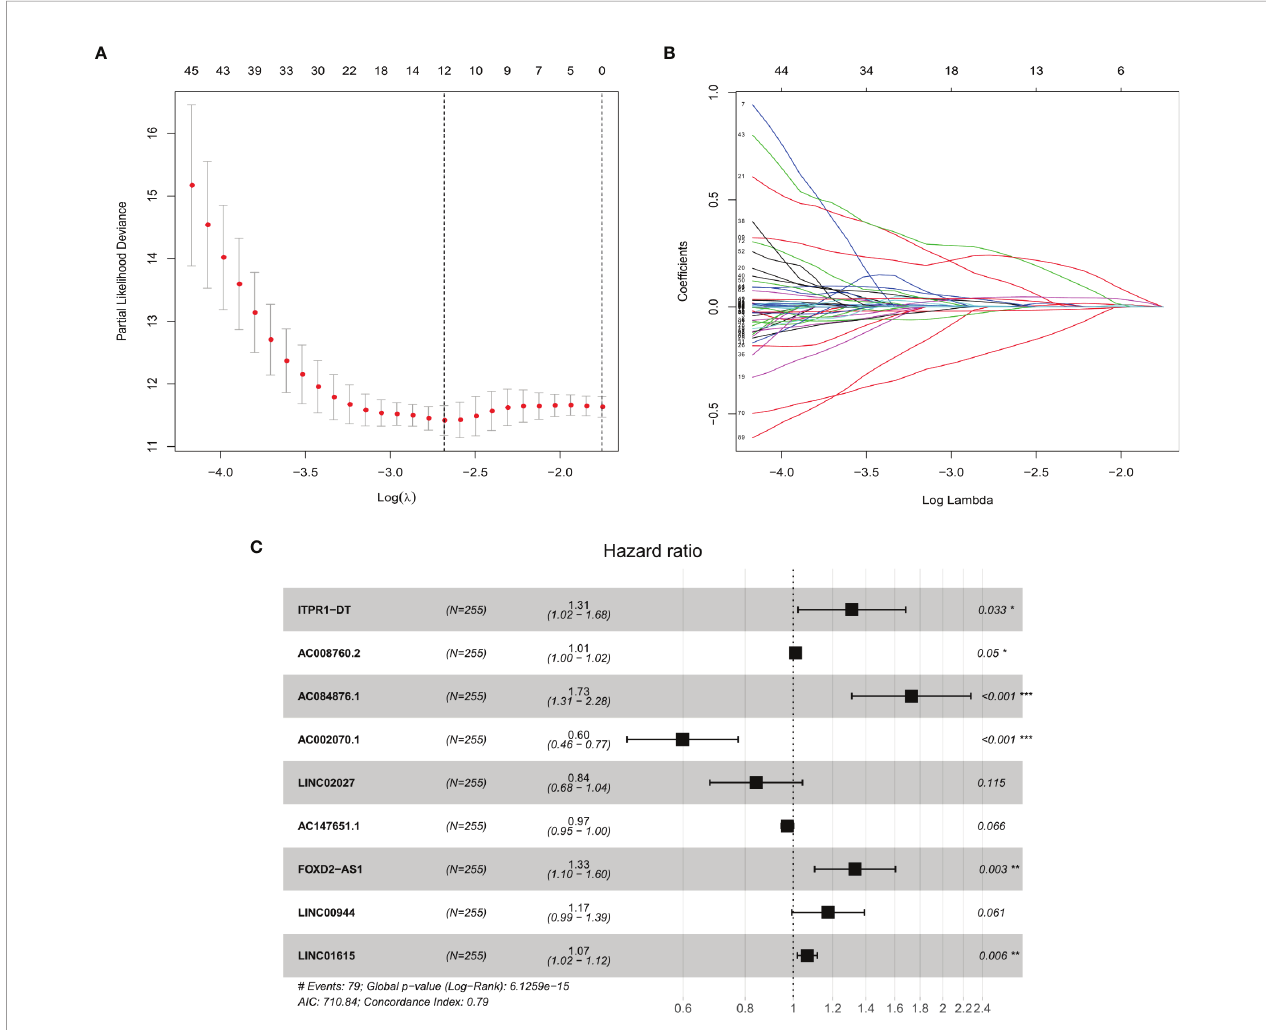
FIGURE 2 | (A, B) The LASSO Cox regression model to identify the most robust lncRNAs. (C) Forest plot of the multivariate Cox regression model showing the nine optimal prognostic hypoxia-related lncRNAs. * represents p < 0.05, ** represents p < 0.01, *** represents p <